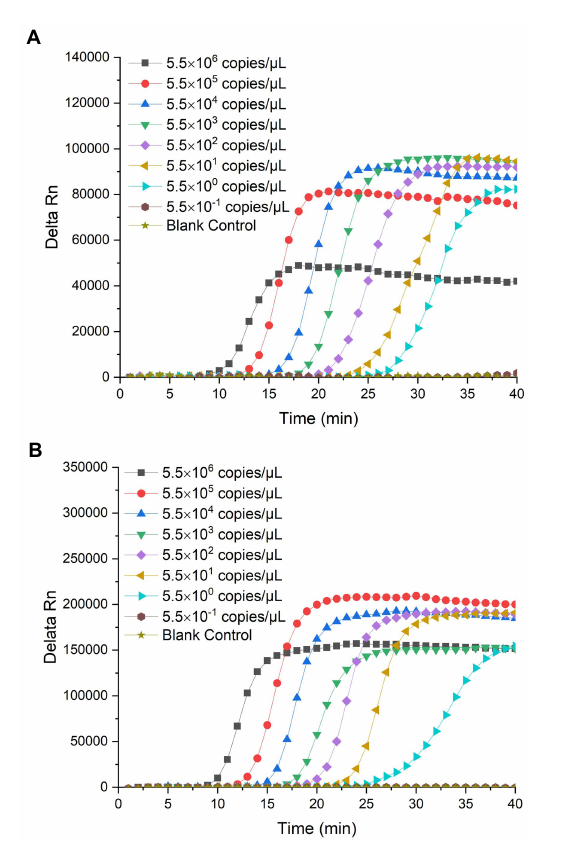
FIGURE 5 (A) Detection limit of Pseudomonas lurida in 10% skimmed milk using RealAmp based on the gyrB gene. (B) Detection limit of Pseudomonas lurida in 10% skimmed milk using RealAmp based on the aprX gene.